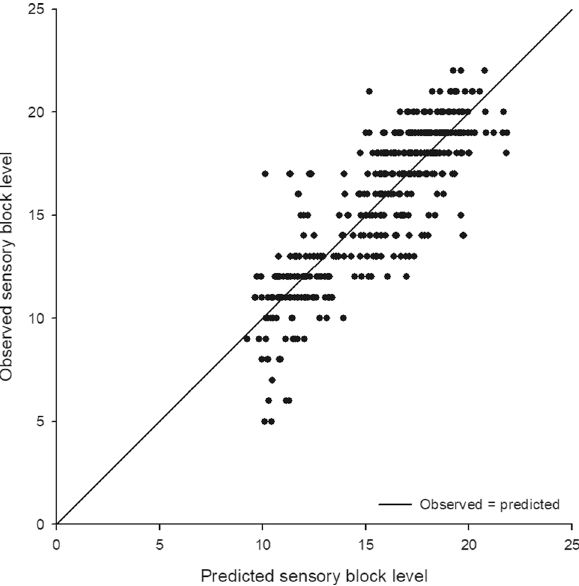
Figure 1. Scatter plot of the predicted and observed sensory block level for the best fit model. The predicted values are calculated using the following formula: 7.12 + 0.88 × (hyperbaric bupivacaine dose in mg) + 1.59 × gender (1 for female, 0 for male) − 0.11 × (height − 162 in cm) + 0.05 × (weight − 68 in kg) + age effect (0.95 for age between 75 and 85; 2.57 for age >